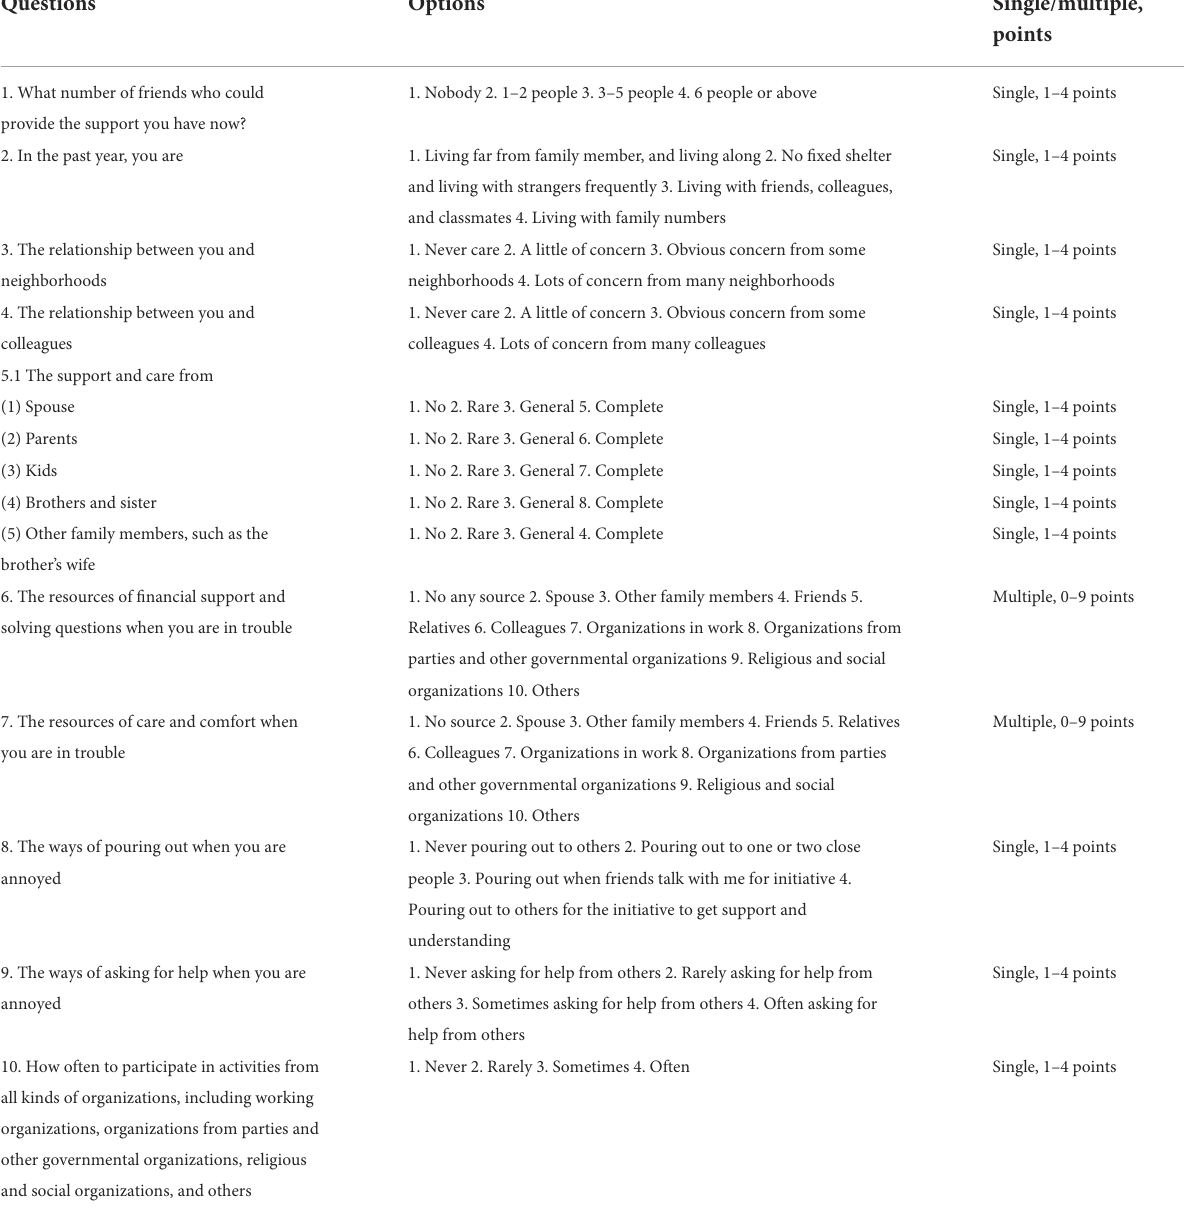
TABLE 1 The questions, options, and points of social support rating scale (SSRC) a